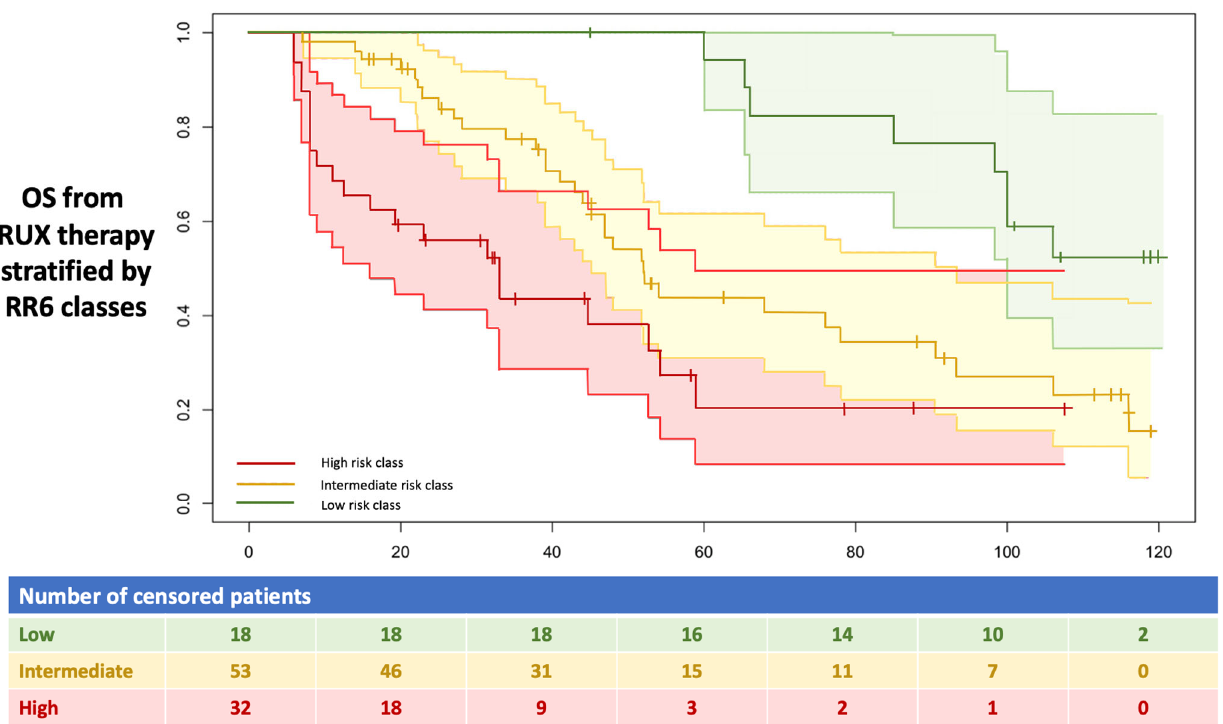
Figure 1. mOS in months starting from the ruxolitinib treatment. All 103 enrolled patients were stratified into three RR6 risk classes, as described in the text. RUX: ruxolitinib.